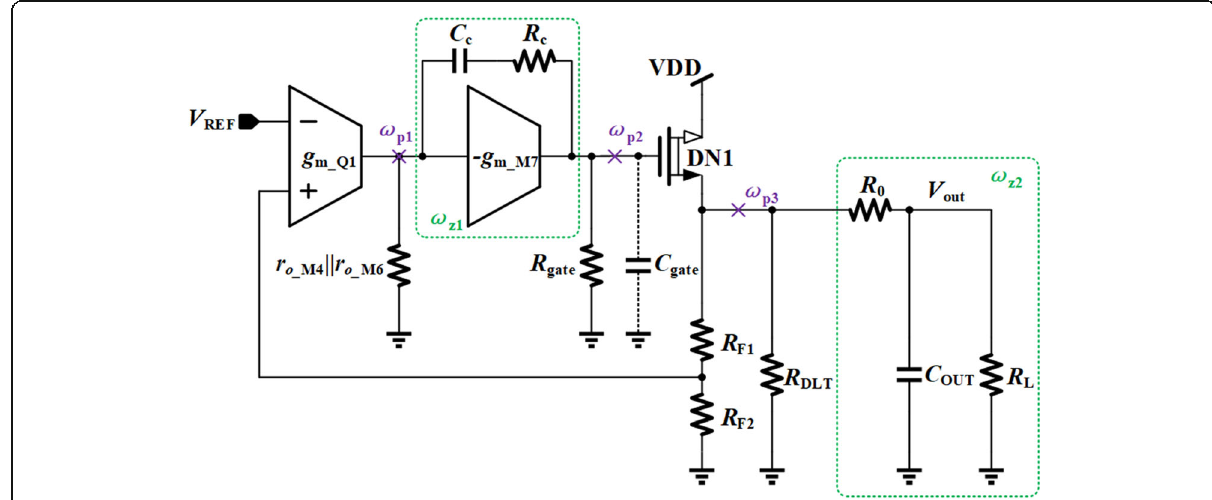
Fig. 5 Poles and zeros distribution of proposed VR